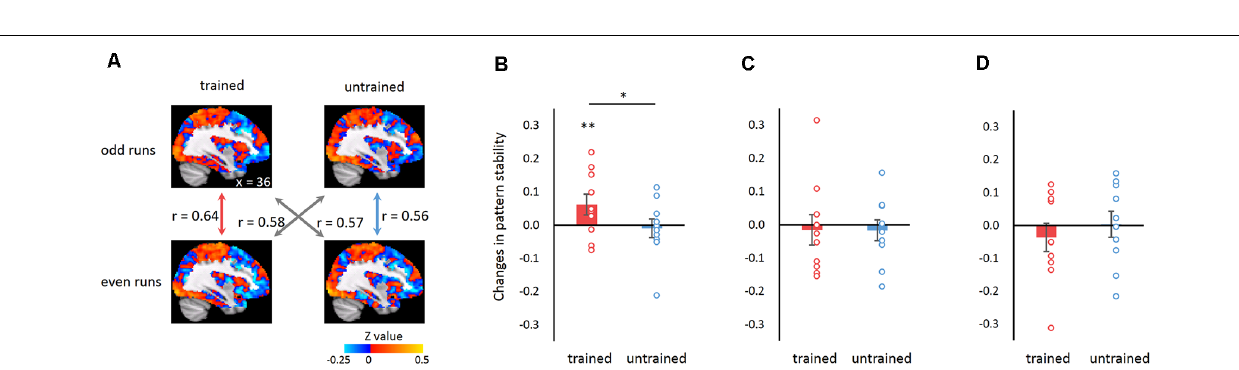
FIGURE 2 | Learning-induced changes in connectivity pattern stability. (A) Illustration of the calculation of connectivity pattern stability. Within-sequence stability was calculated as the Pearson correlation coefficient of the functional connectivity (FC) maps between the even and odd runs for the trained (red) and the untrained (blue) sequence, respectively. Between-sequence stability was calculated identically but between the trained and untrained sequences (gray). Images show the FC maps after the baseline period FC maps were subtracted for an exemplar participant in the post-training scanning session. The z -values are the result of Fisher’s transform of the correlation coefficients. (B–D) Changes in connectivity pattern stability (after vs. before training) for trained and untrained sequences when connectivity was calculated using the right M1 as the seed (B) , using the left M1 as the seed (C) , and when participants performed the finger-tapping with the untrained hand (D) . Error bars denote SEM. ∗ p < 0.05, ∗∗ p <